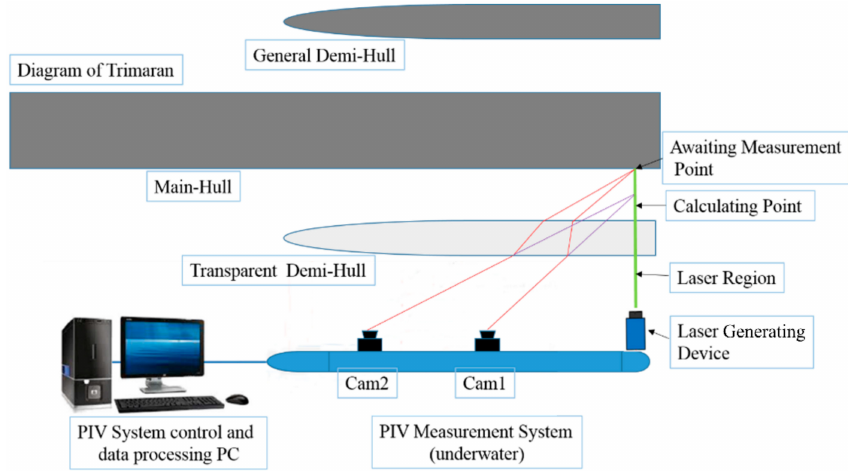
Figure 9. Schematic of the optical paths.